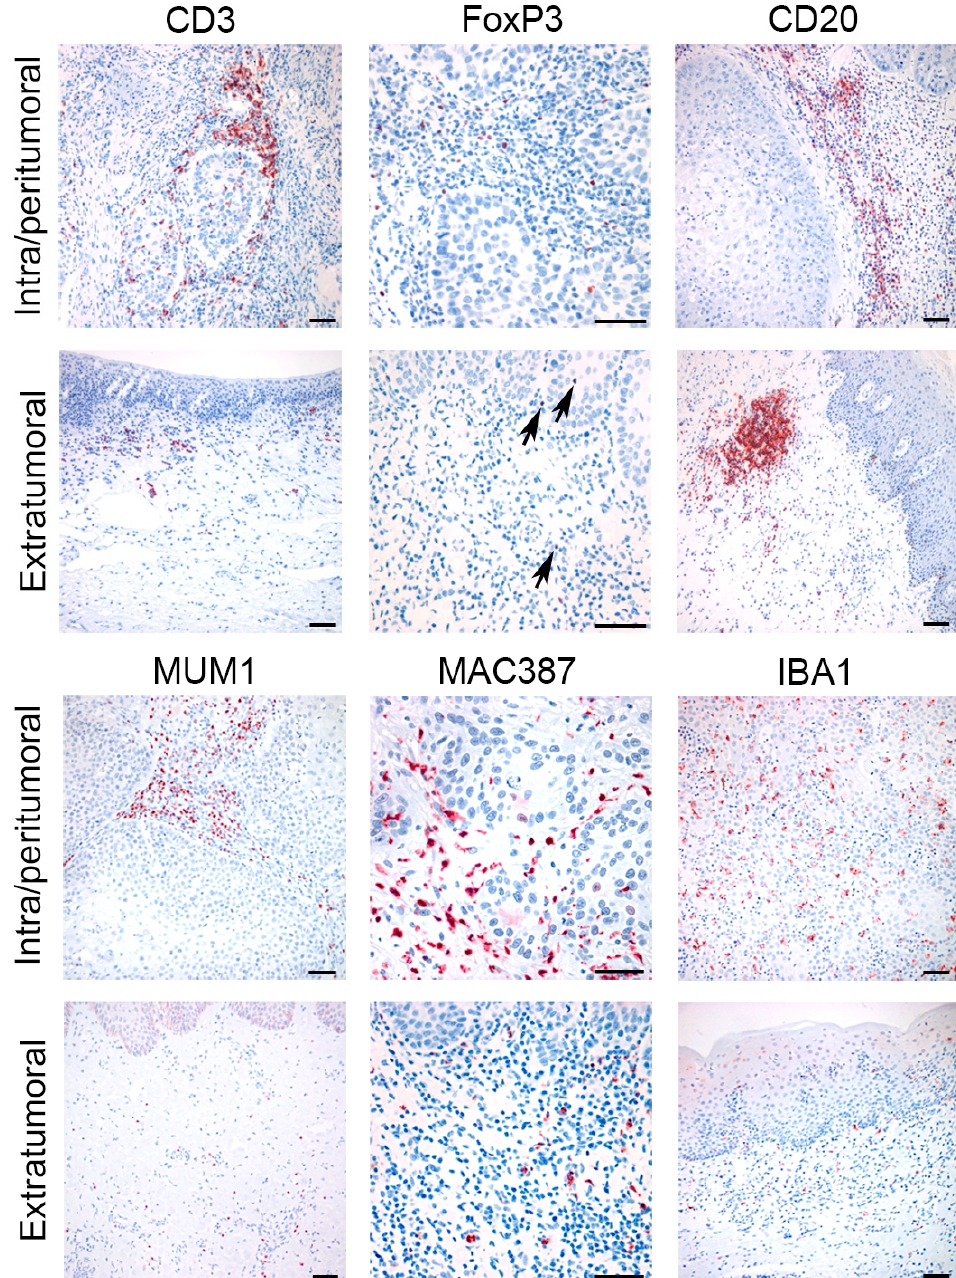
Figure 1. Immunohistochemical expression of different immunohistochemical markers for immune cell population in intra/peritumoral areas of epSCCs and in the extratumoral tissues. CD3 cells were arranged in aggregates within the tumor stroma and, occasionally, also within tumor lobules. FoxP3 cells were numerous within the tumor and scattered in extratumoral tissues (arrows). CD20 could be observed in extratumoral tissues as follicular aggregates (MALT). MUM1, MAC387, and IBA1 cells were more numerous within the tumoral stroma, when compared to the extratumoral tissues. Scale bars: 200 microns.